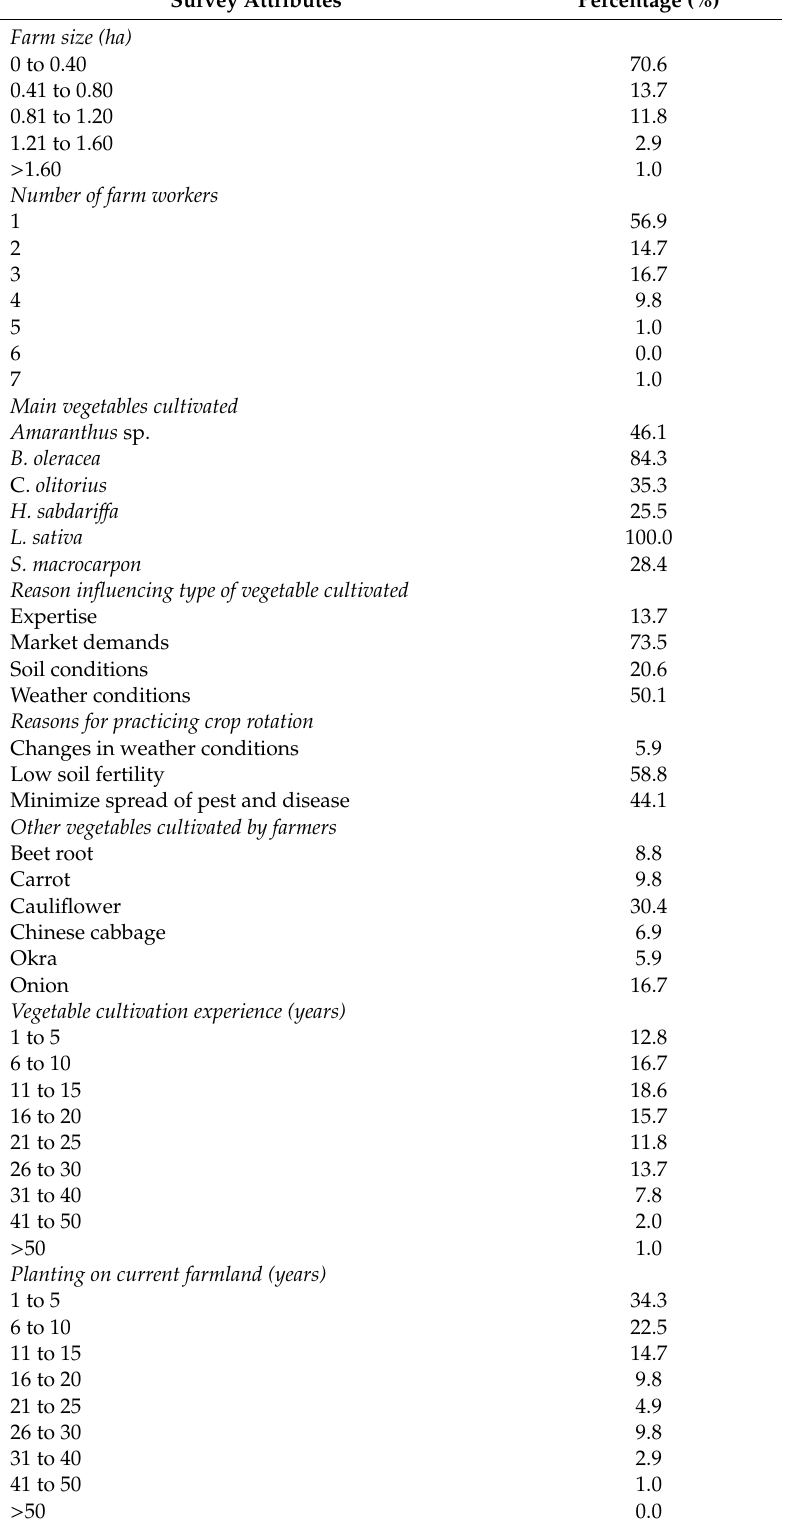
Table 2. Characteristics of participating vegetables farms in Accra, Ghana. Survey